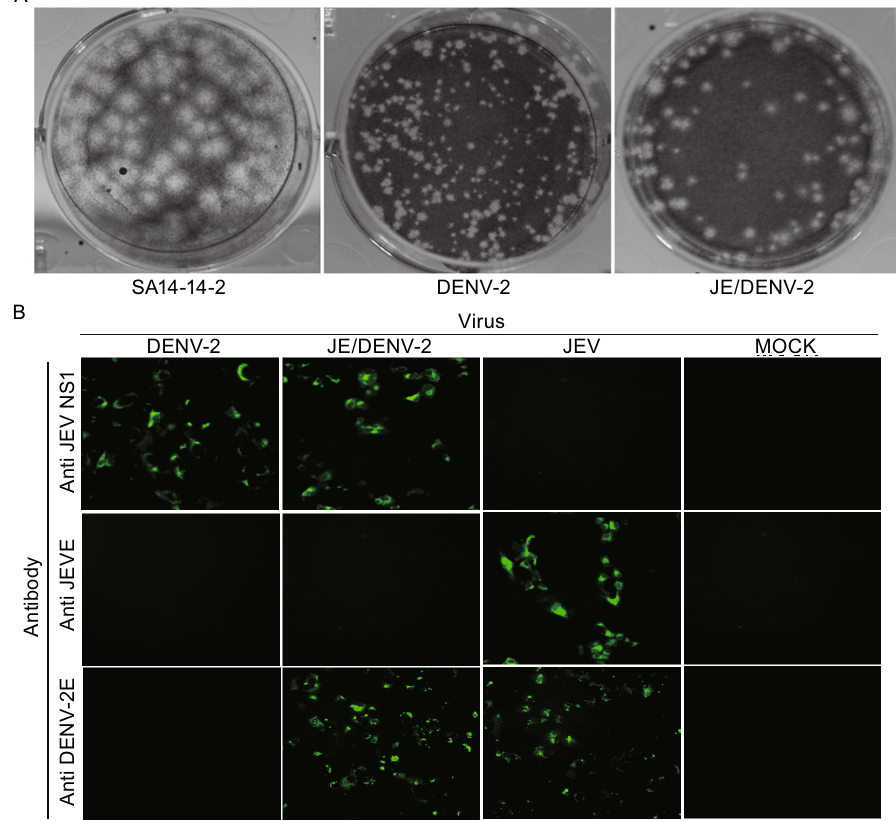
Figure 1. The diameter of plaque and viral proteins expression of JEV, JE/DENV-2 and DENV-2 in BHK21 cells . (A) The formation and diameter of plaques in BHK21 cells. (B) BHK21 cells were infected with each of these three viruses. Immuno fl uorescence staining was performed using antibodies recognizing DENV-2 E protein (1:10 dilution, top panel), JEV E protein (1:10 dilution, mid panel), or JEV NS1 protein (1:10 dilution, bottom panel). Mock represents no virus infection. DENV, dengue virus; JEV, Japanese encephalitis virus; JE, Japanese encephalitis; E, envelope protein; NS: non-structural